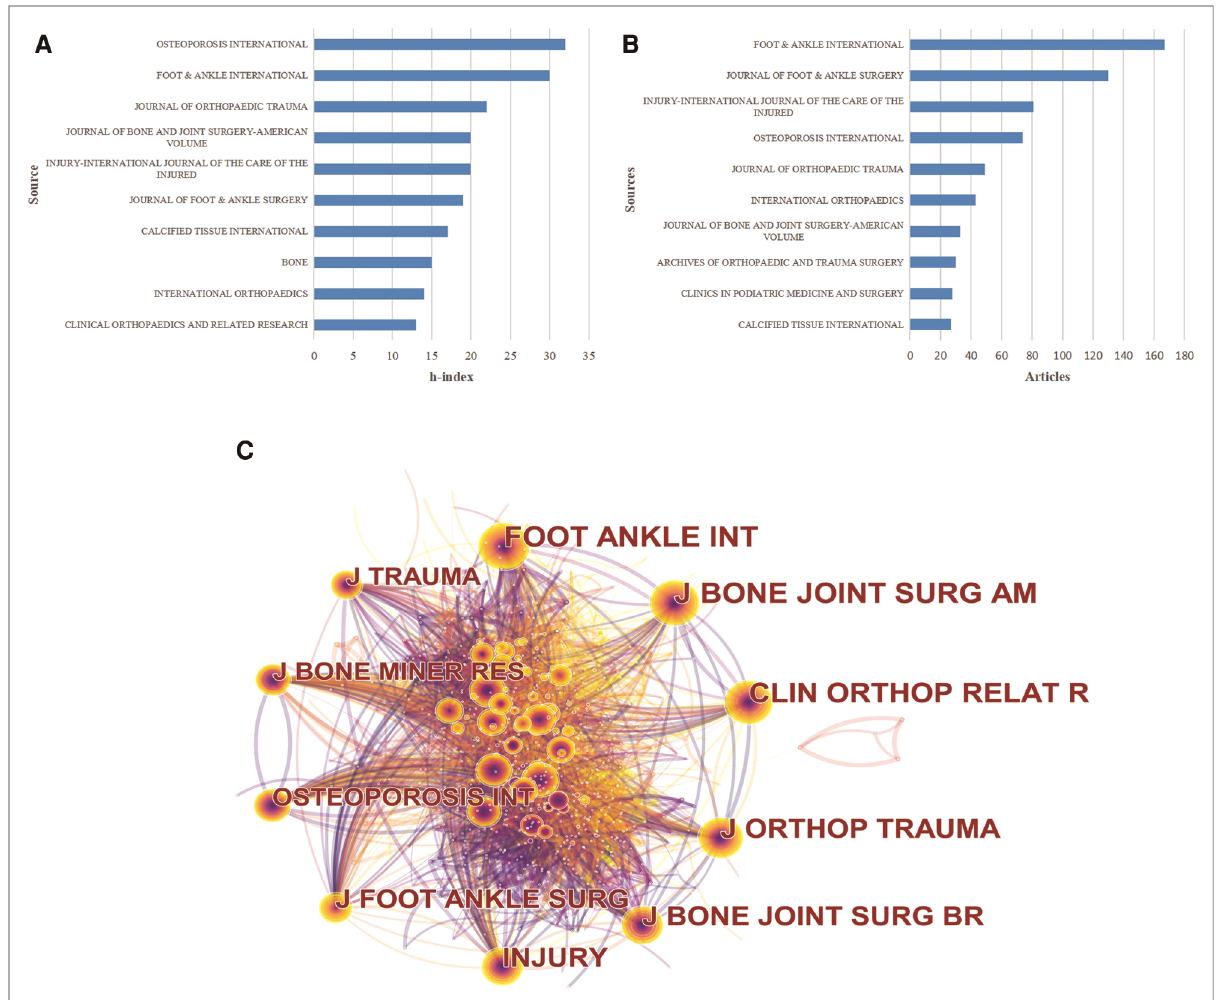
FIGURE 5 The distribution of journals publishing research on calcaneal fractures. ( A ) The top 10 journals publishing research in the fi eld of calcaneal fracture, ranked by H-index. ( B ) The top 10 journals publishing research in the fi eld of calcaneal fracture, ranked by article count. C ) Network map of co-cited journals (generated by VOSviewer). Each node represents a different journal, and the node size is proportional to the number of citations; the larger the node, the greater the citation